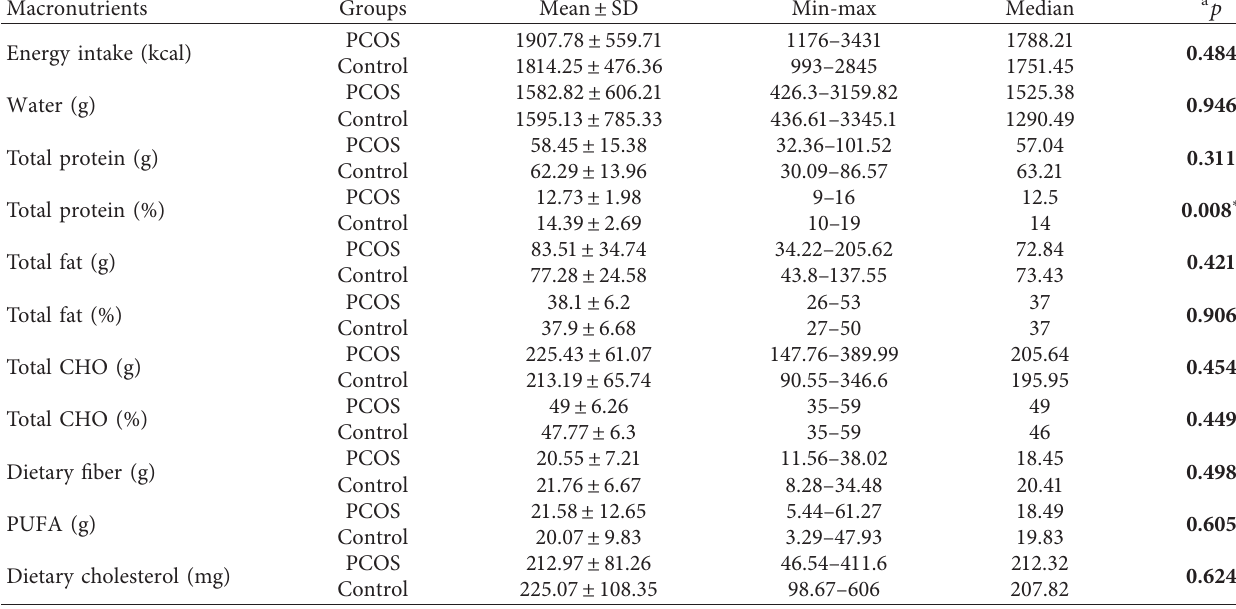
Table 5: Daily energy intake and macronutrient components of PCOS and control.